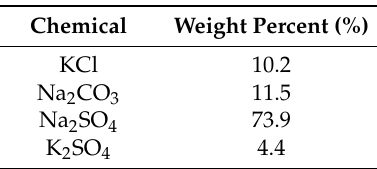
Table 1. Composition of the simulated salt